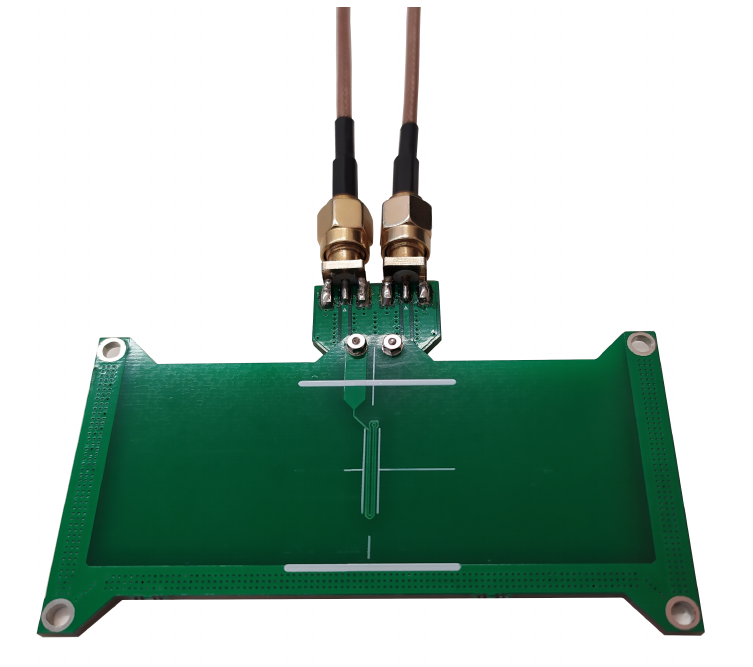
Figure 4. Adapter and planar coil on the printed circuit board used for the experimental